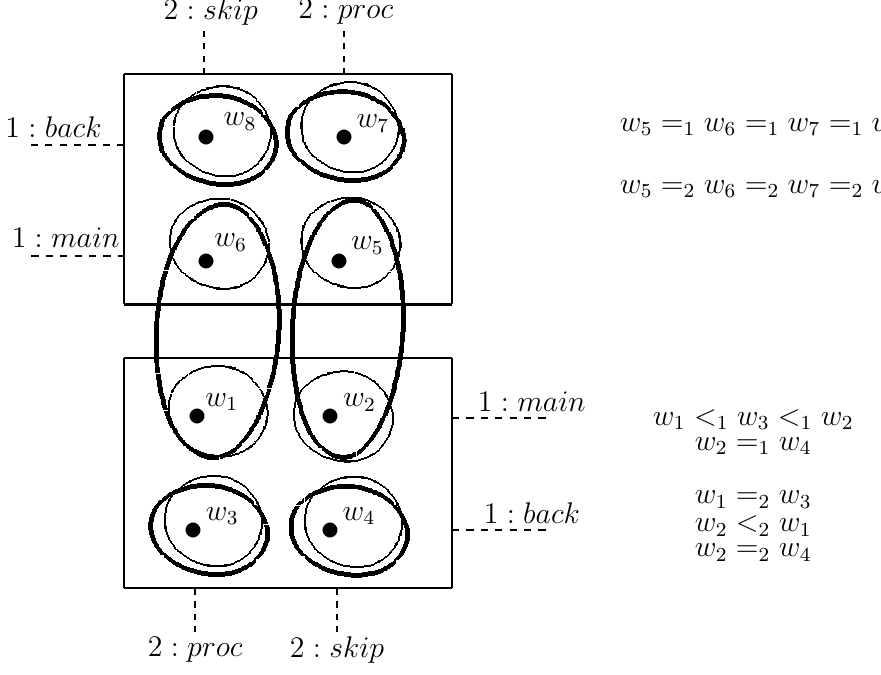
Figure 3. Alarm Game. Again thick circles represent epistemic possibility relations for agent 1 whereas thin circles represent epistemic possibility relations for agent 2 . The two equivalence classes ∼ ( w two different games where agents have different preference ordering over strategy